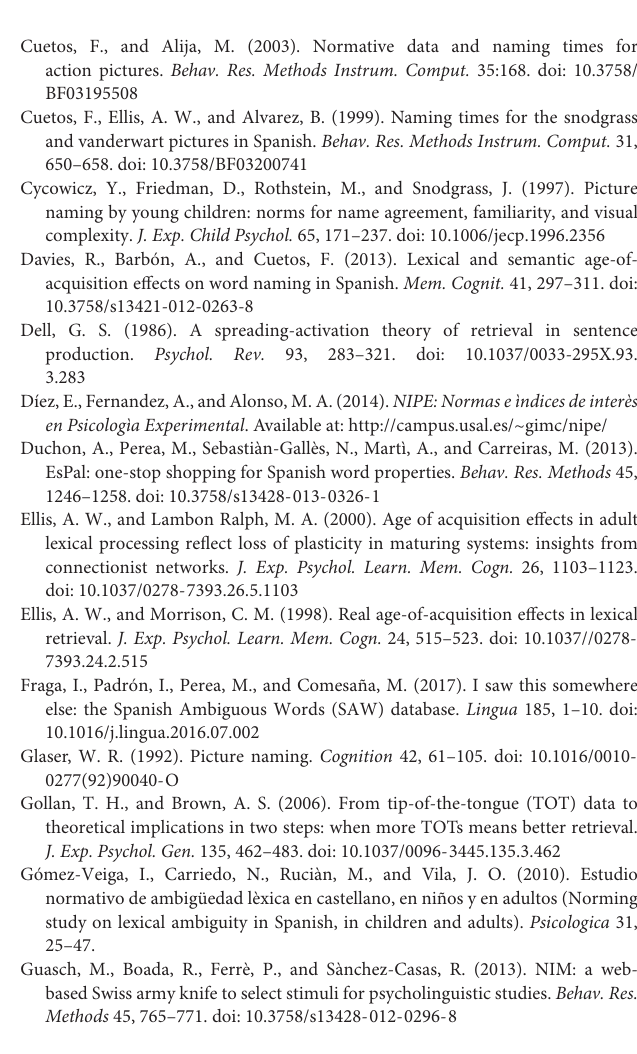
TABLE S1 | Normative data for 295 ARASAAC